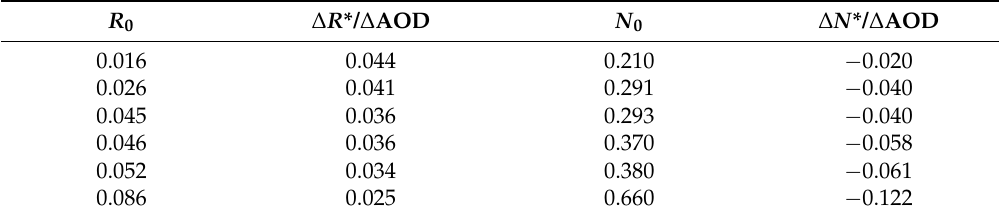
Table 2. Case study of surface reflectance in red ( R 0 ) and NIR ( N 0 ) channels and sensitivity of apparent reflectance ( R * and N *) to AOD variations. R 0 ∆ R */ ∆ AOD N